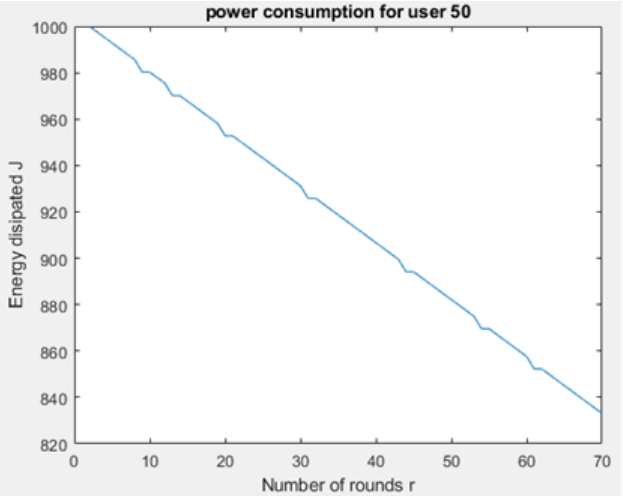
Figure 32. Delay time at BS No. 24 in conventional NB-IoT.